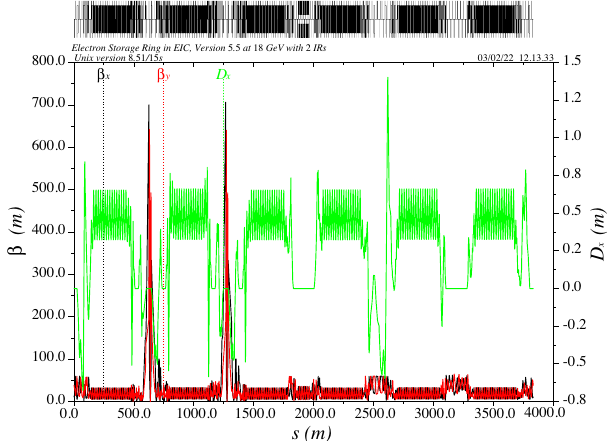
FIG. 3. Lattice functions in the electron storage ring with two interaction points starting from the center of straight-4.